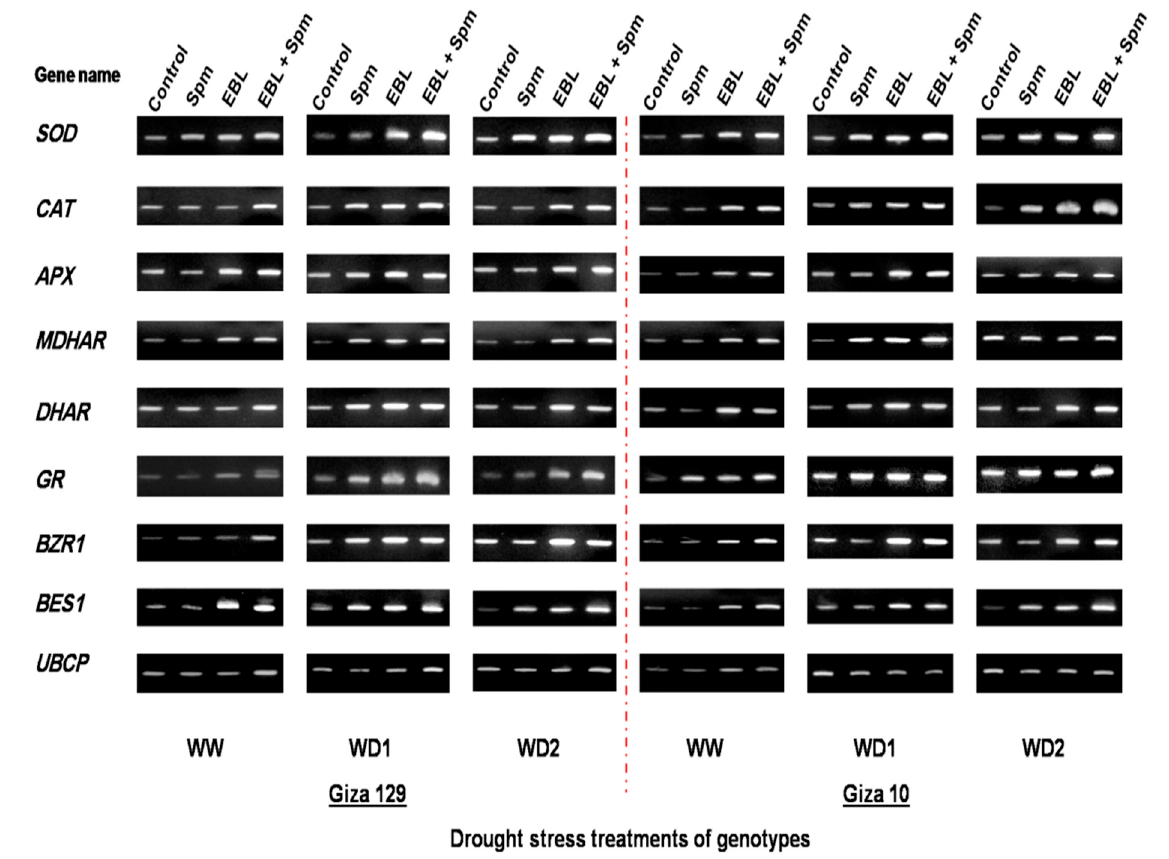
Figure 1. Semi-quantitative RT-PCR analysis of ZmSOD : superoxide dismutase; ZmCAT : cata- lase; ZmAPX : ascorbate peroxidase; ZmMDHAR : monodehydroascorbate reductase; ZmDHAR : dehydroascorbate reductase; ZmGR : glutathione reductase; Zea mays protein BZR1 homolog 1-like ( ZmBZR1 );and Zea mays protein BES1 ( ZmBES1 ) genes in comparison to the ubiquitin carrier protein ( ZmUBCP ) gene as an internal control for leaves of maize plants after seven days of foliar application with distilled water (control), 25 mg L − 1 Spm, 0.1 mg L − 1 EBL, or 25 mg L − 1 Spm + 0.1 mg L − 1 EBL to both genotypes—Giza 129 and Giza 10—exposed to drought stress treatments (control (100% field capacity (FC); WW) and water deficit (75% FC and 50% FC; WD1 and WD2)).